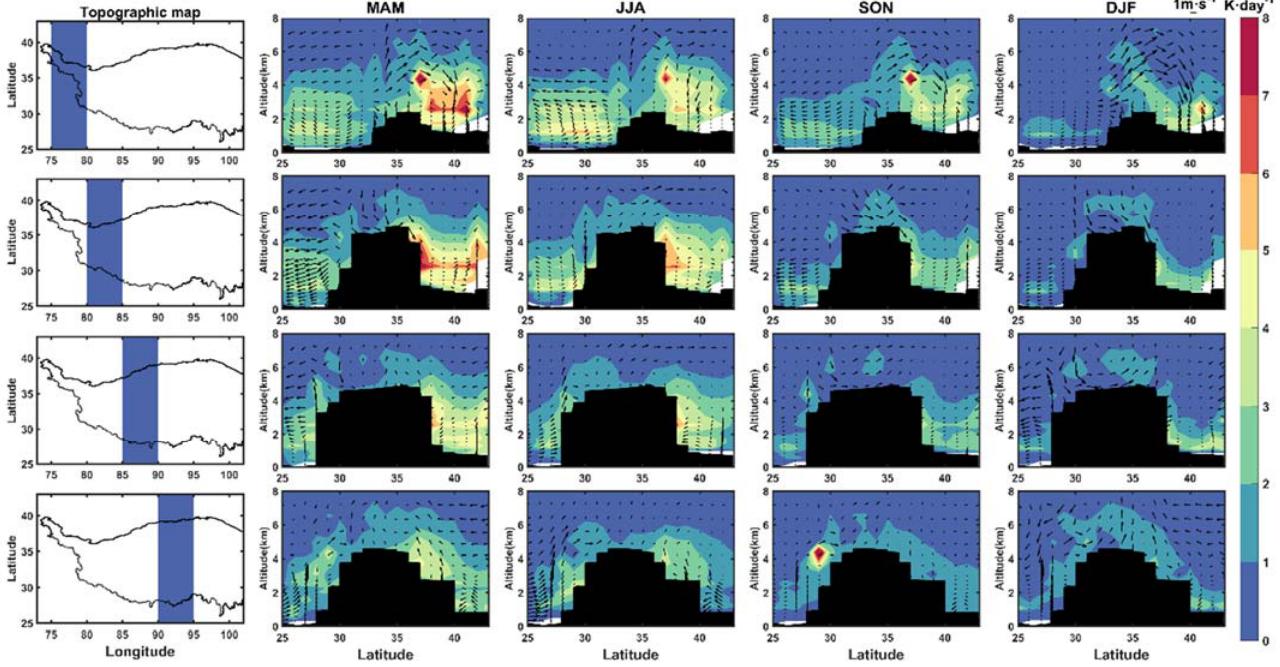
Figure 12. The seasonal distributions of SW DHR and wind field on four longitudinal transects during 2007 − 2020.